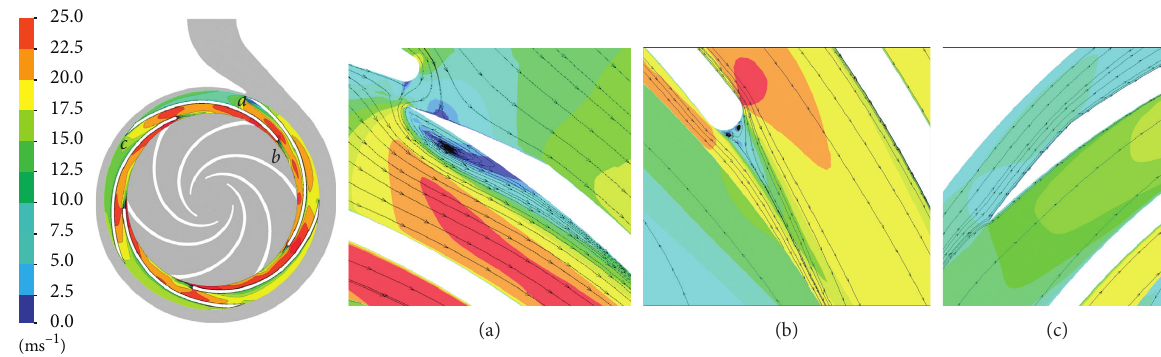
Figure 12: Streamlines in guide vane at ( Q ) � 48m 3